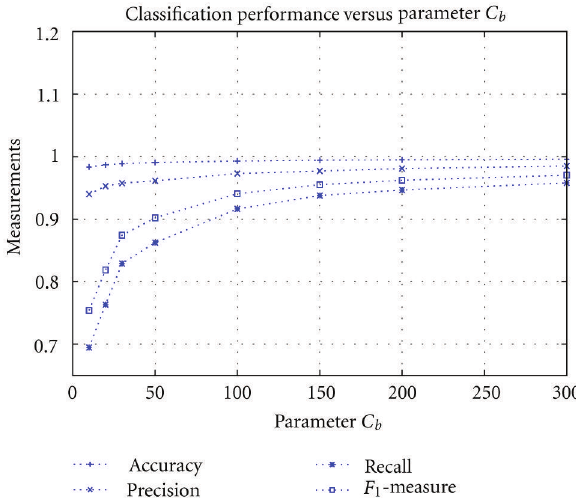
Figure 6: Performance measures of SVM model for Attack